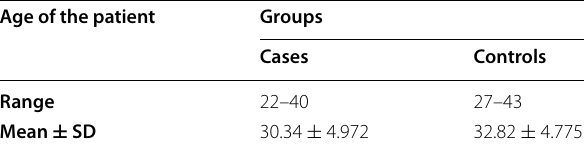
Table 1 Descriptive analysis of the age variable Age of the patient Groups